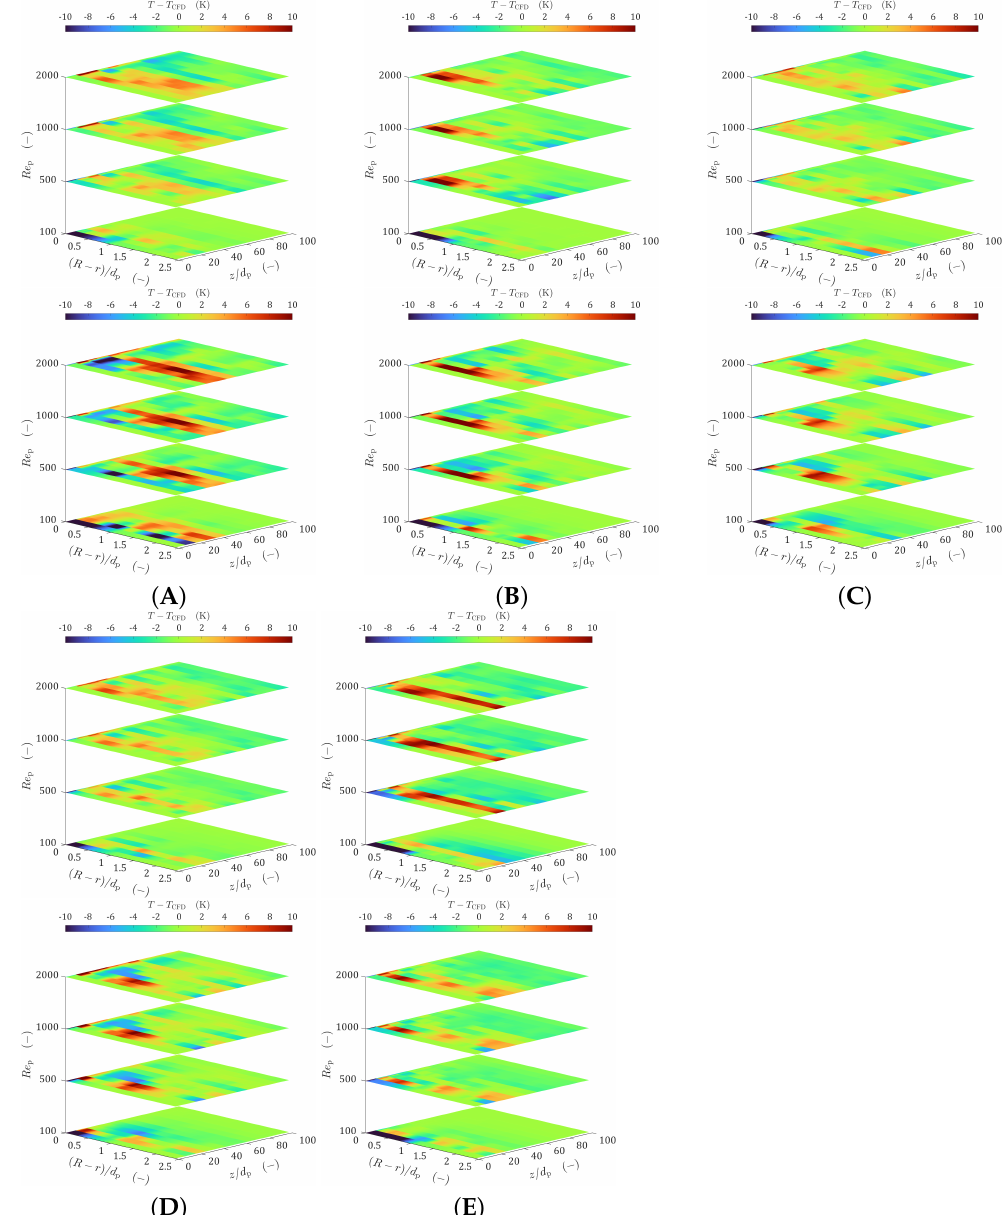
Figure 10. Deviation of the λ eff,r ( r ) model results (correlation of Winterberg) in comparison to particle-resolved CFD data, for loose (top) and dense (bottom) packings of ( A ) spheres, ( B ) cylinders, ( C ) rings, ( D ) four-hole cylinders, and ( E ) spheres with the wall